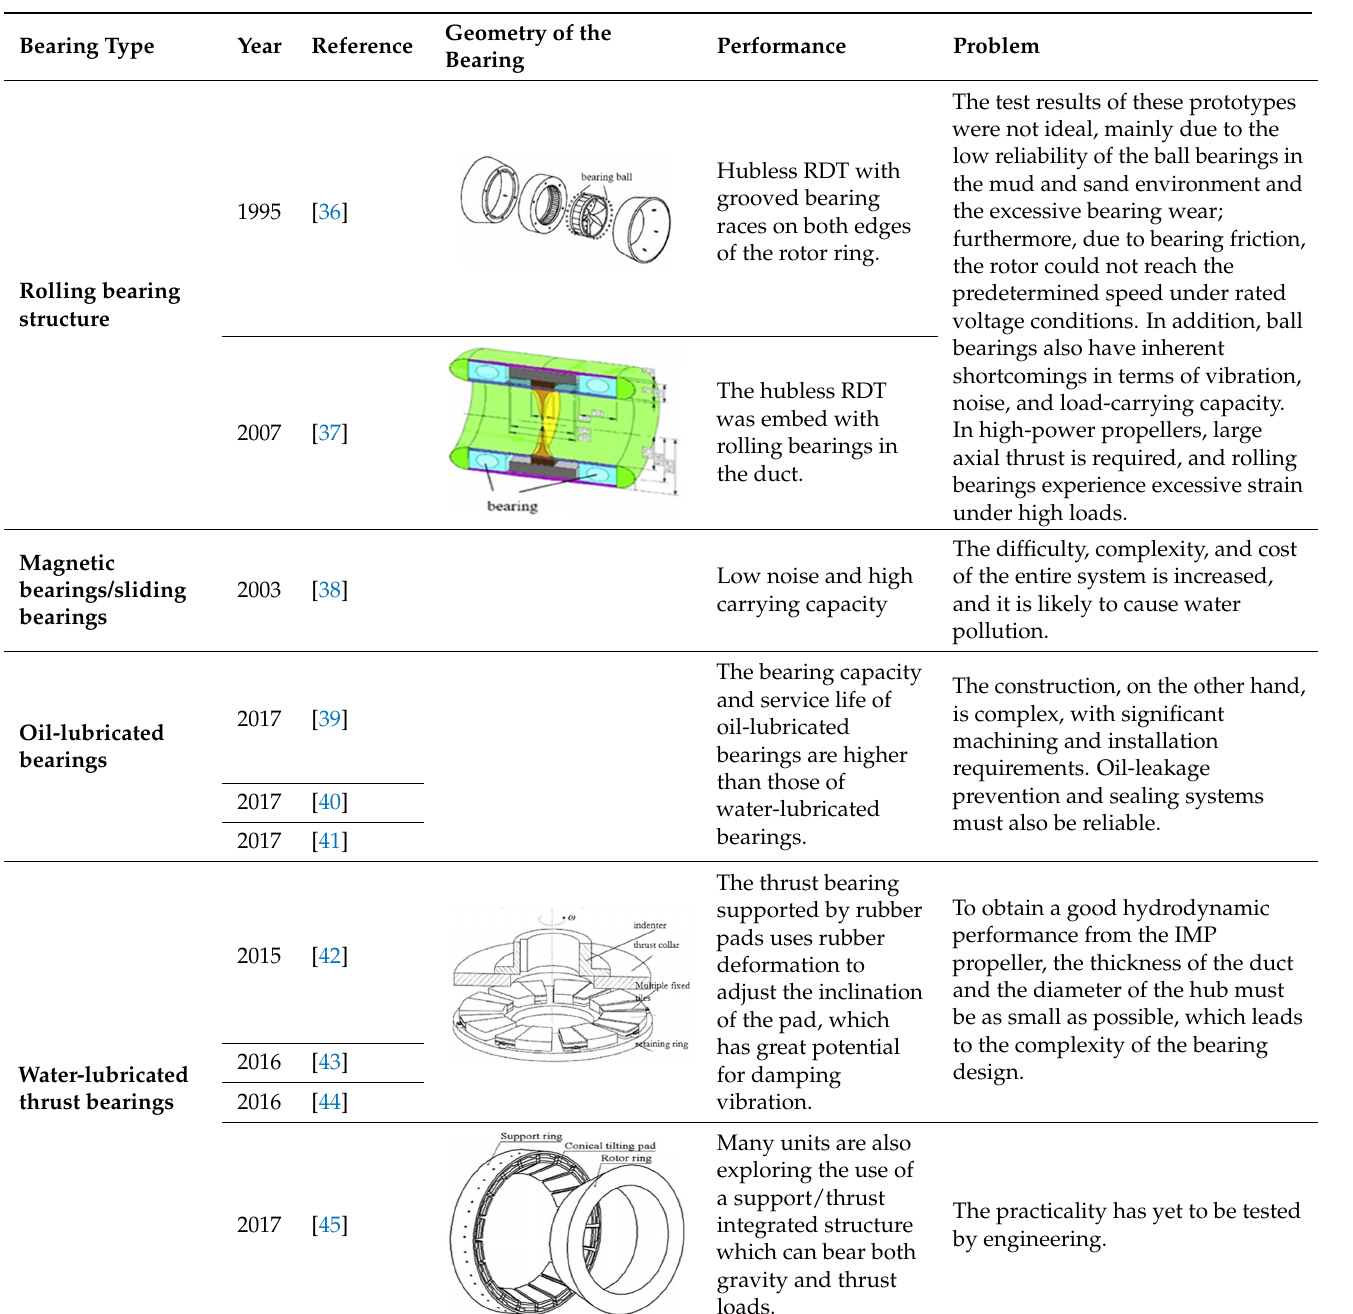
Table 2. Types of bearings applicable to IMP.